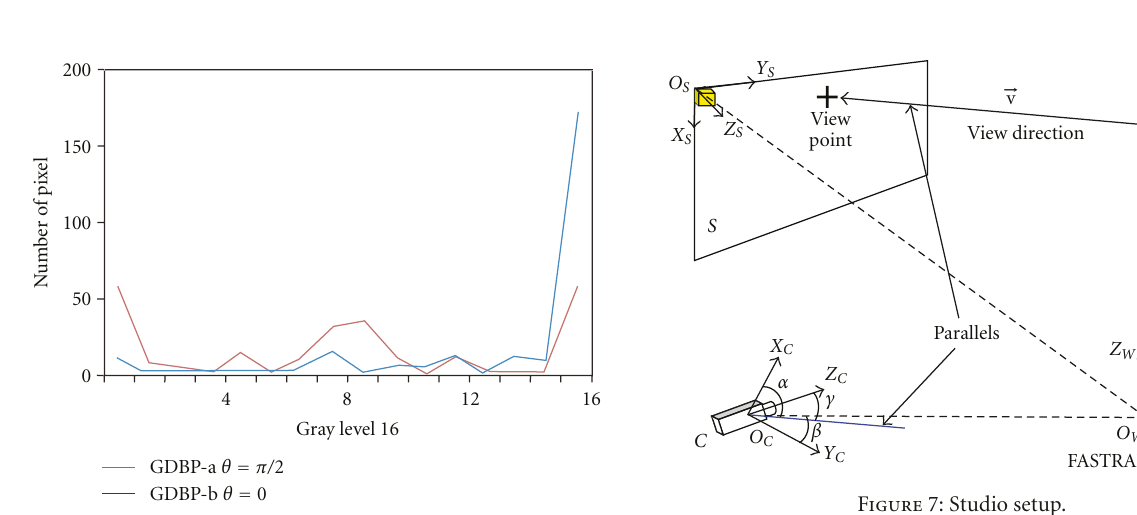
Figure 5: Samples under three lighting variations.